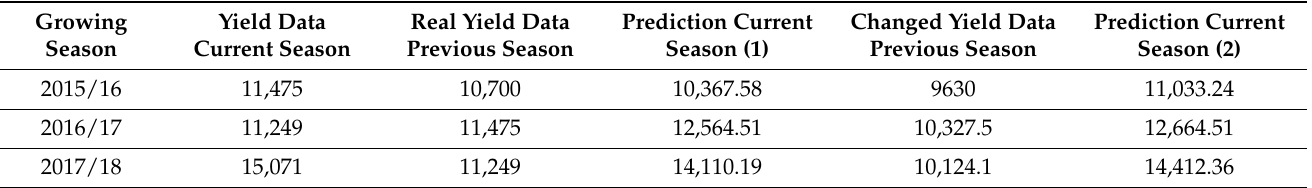
Table 6. Comparison in yield data prediction (Kg) by changing the key parameter by 10%. Analysis for three selected growing seasons. (1) Prediction using real values for the key parameter and (2) prediction using the key parameter value modified by